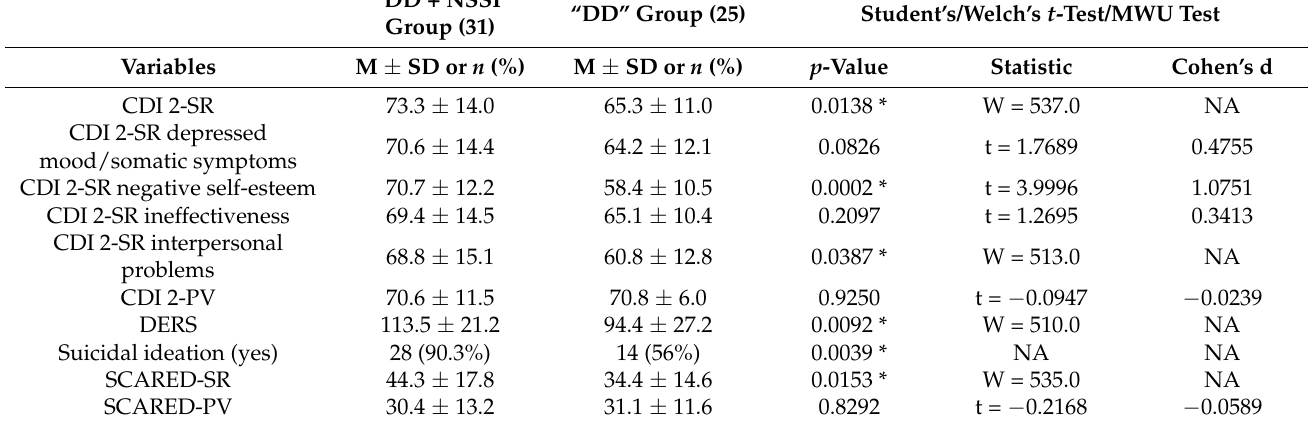
Table 3. Between-group statistical comparisons of clinical variables in patients suffering from de- pression who endorse NSSI (“DD + NSSI” group) versus patients who do not endorse NSSI (“DD”